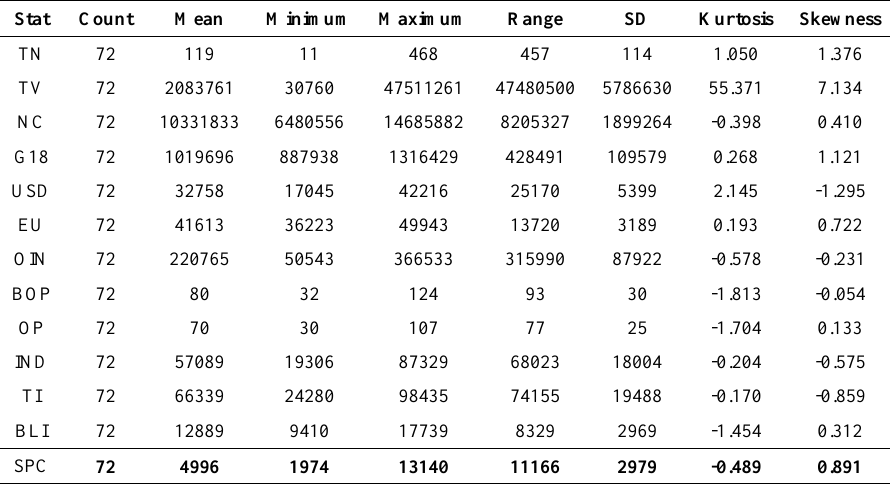
Table 2. Descriptive statistics for all variables available in stock marketing